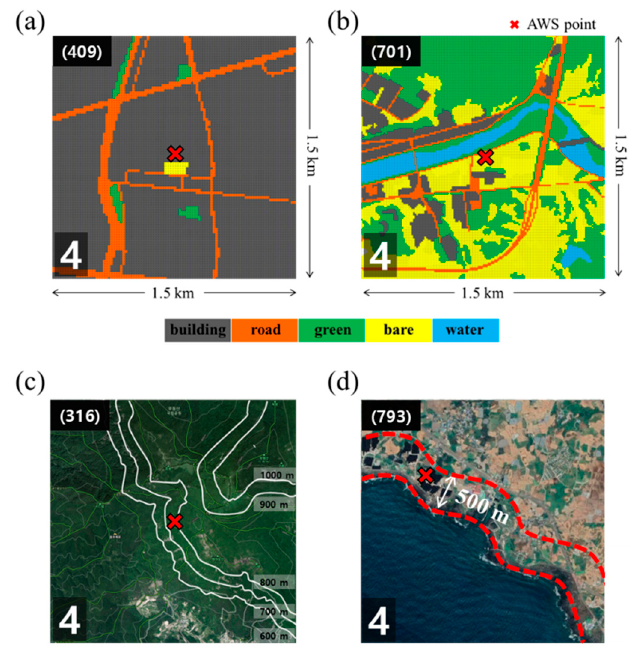
Figure 1. Classification of the automated weather stations (AWSs) for land-use ( a , b ) and topography types ( c , d ). Red symbols and white solid lines in ( c ) represent AWSs and contour lines, respectively. The deviant crease lines in ( d ) indicate the area within 500 m from the coastline.